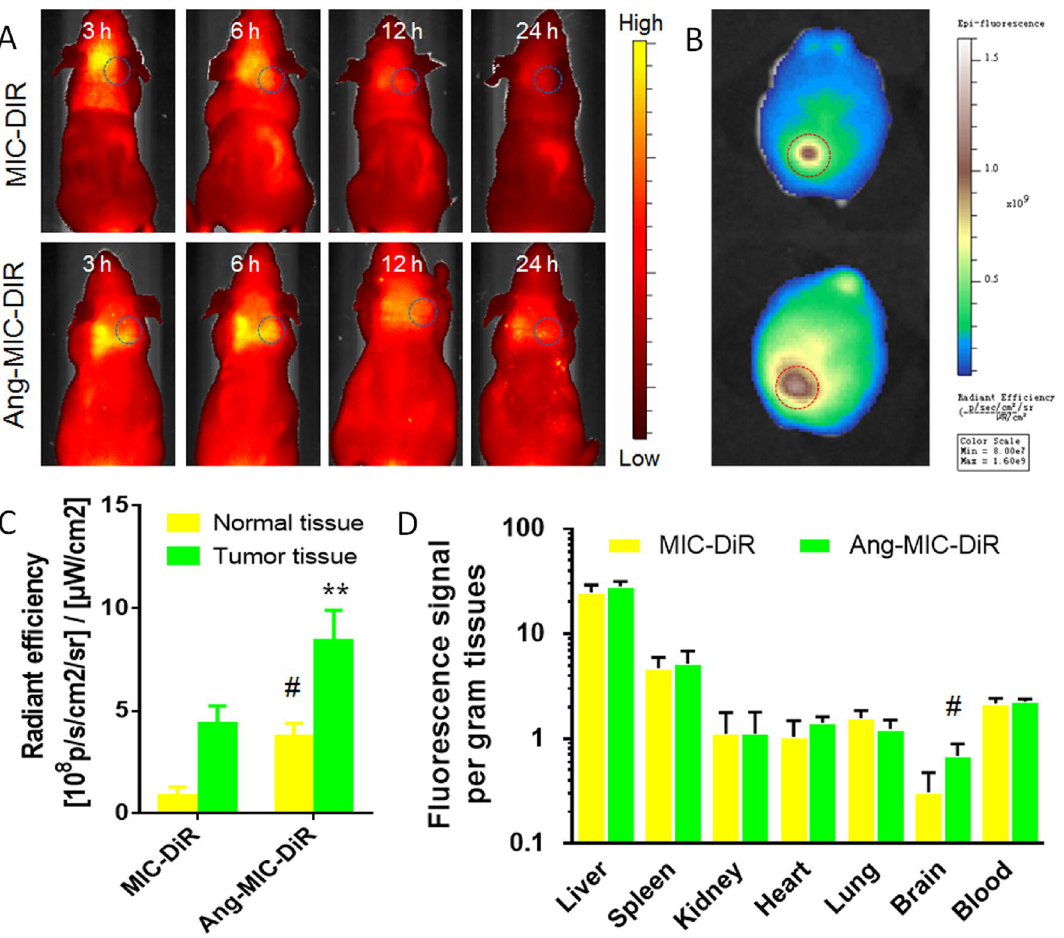
Figure 5. Brain tumor accumulation of Ang-MIC. ( A ) In vivo imaging of tumor-bearing mice administrated with DiR-labeled Ang-MIC. ( B ) Ex vivo imaging of brains and ( C ) semi-quantification results of fluorescence of brain tumor tissues 24 h post micelle injection. ( D ) Biodistribution of Ang-MIC 24 h post micelle injection (n = 3). # P < 0.05, ** P < 0.01, compared with